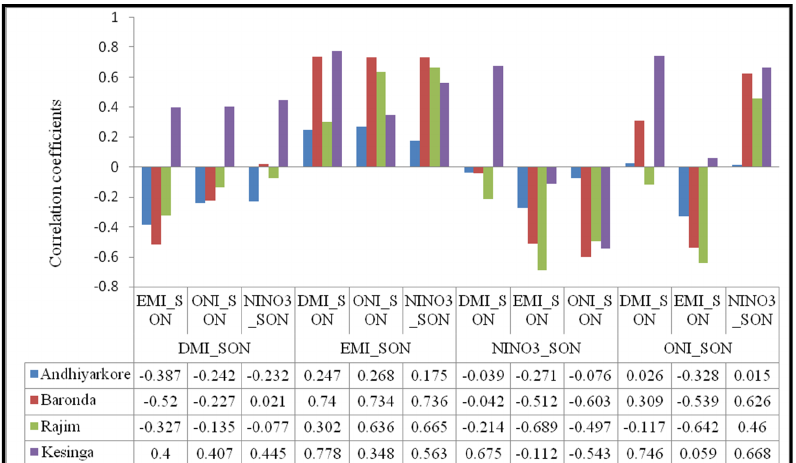
Figure 4. Partial correlation of ONI, EMI, DMI and Nino3 with streamflow anomalies at four selected stations for the SON season. Here, it is to be noted that partial correlation between streamflow and ONI has excluded the influence of DMI, EMI, and Nino3. Same process was done to DMI, EMI, and